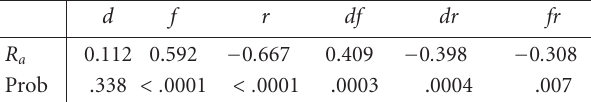
Table 8: Pearson correlation coe ffi